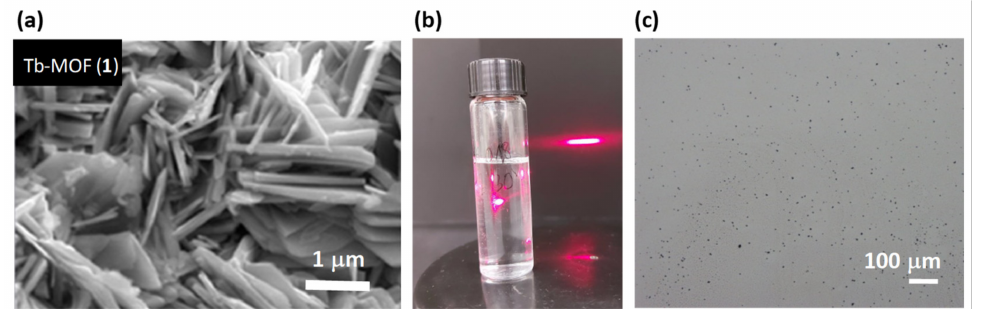
Figure 2. Exfoliation process from ( 1 ). ( a ) SEM image of crystals of 1 (bulk), ( b ) Tindall effect of a suspension of delaminated 1 , ( c ) flakes of 1 deposited onto a silicon wafer.